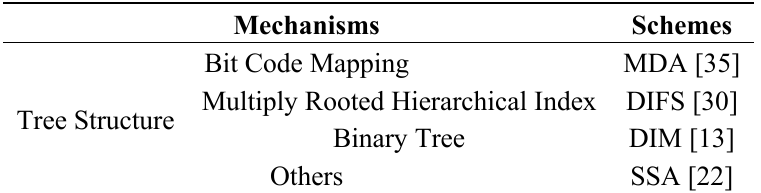
Table 1. Summary of Range-Query Data-Centric Storage (DCS) Schemes.